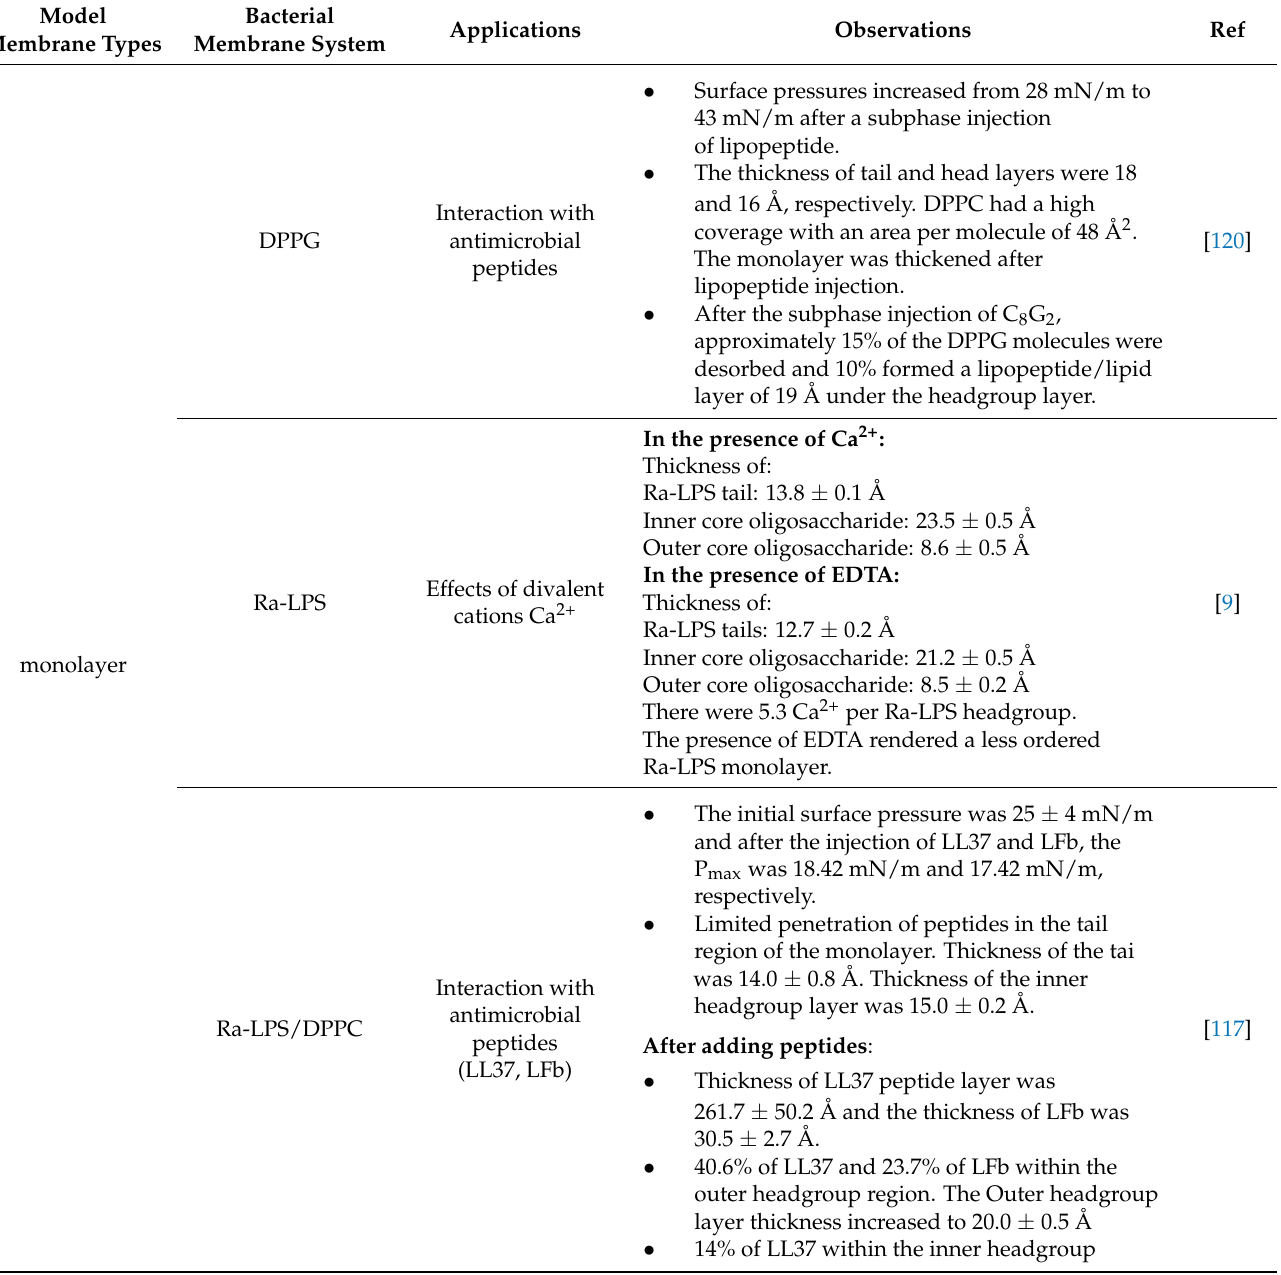
Table 1. Summary table for the recent studies exploiting Gram-negative bacterial membrane